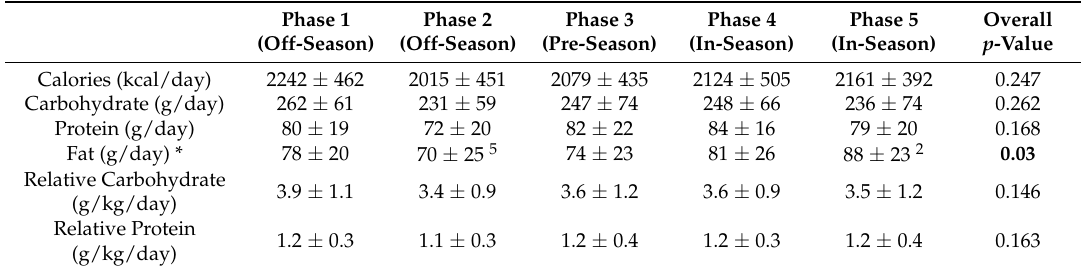
Table 3. Self-Reported Caloric and Macronutrient Intake across the Academic Year.